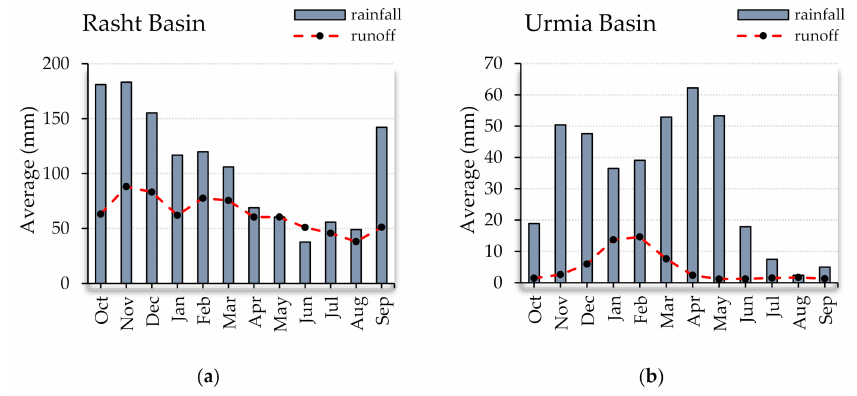
Figure 3. Average monthly rainfall and runo ff in: ( a ) Rasht Basin; and ( b ) Urmia Basin.